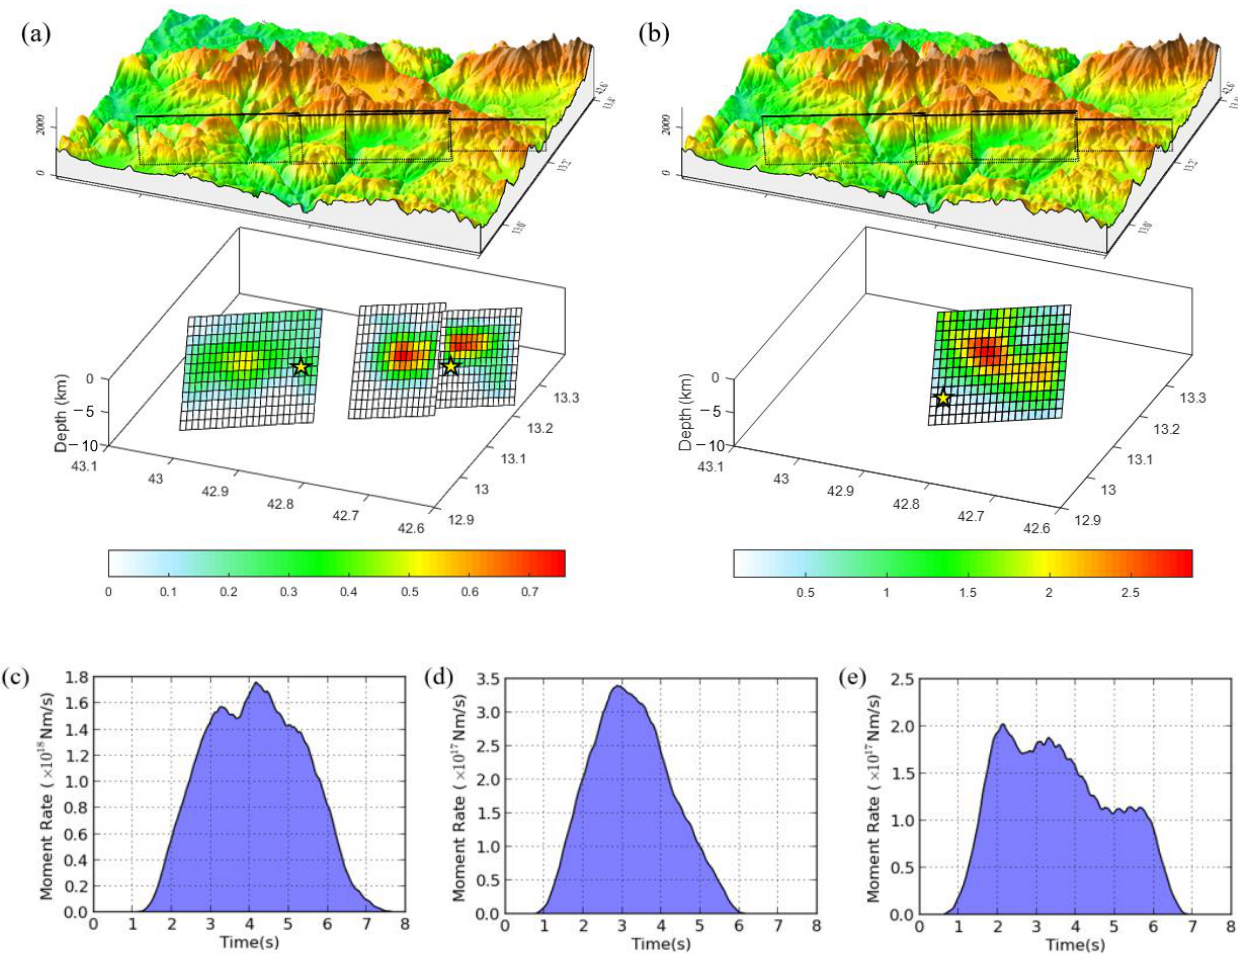
Figure 2. The inverted joint slip models for the 2016 central Italy earthquake sequence. ( a ) Distributions of slip at depth for the Visso (left) and Amatrice (right) earthquakes. The yellow stars denote the start point for the ruptures. ( b ) Distributions of slip at depth for the Norcia earthquake. ( c – e ) The moment rate functions of the Visso, Amatrice, and Norcia earthquakes, respectively.